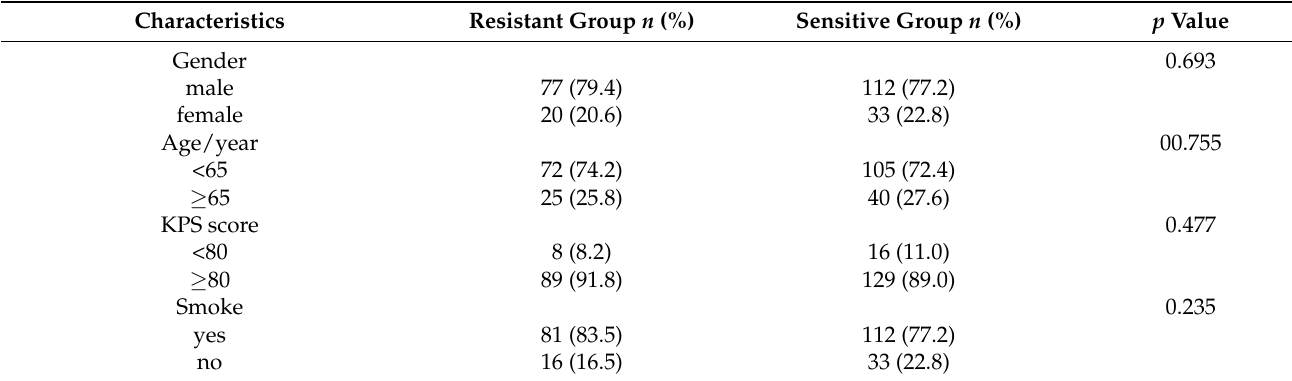
Table 1. Patient characteristics by sensitivity to first-line